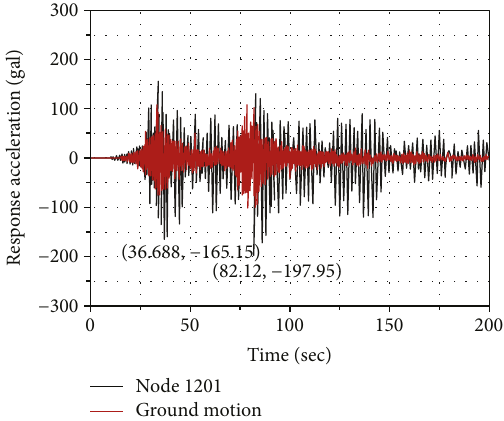
Figure 21: Time history of pore water pressure for element 681 and element 865 during dynamic analysis.